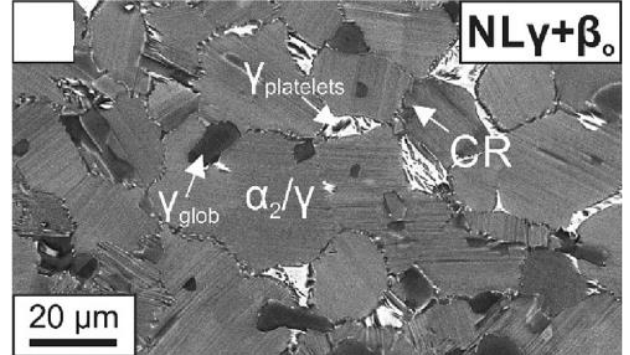
Figure 1. BSE image showing microstructure TNM-Forged-NLGB. Reprinted with permission from Ref. [6]. 2018, M. Kastenhuber et al.